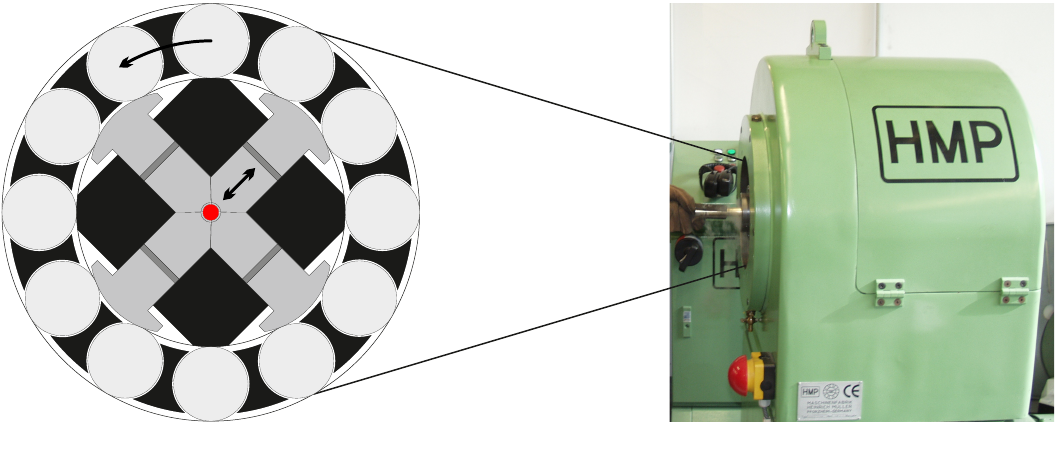
Figure 1. Sketch and picture of a rotary swaging machine, used for